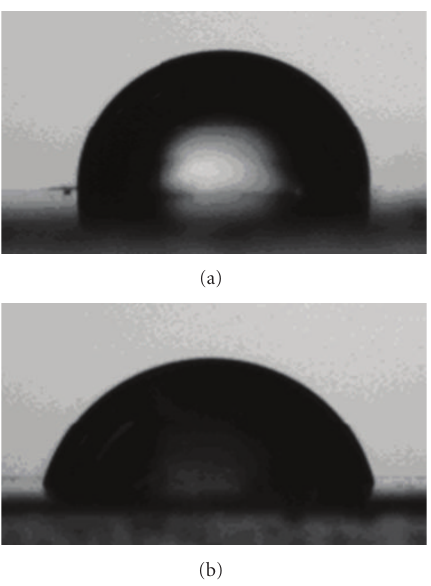
Figure 4: Di ff erences in the hydrophobic character of (a) Nafion- 112 and (b) Naf-112/DTA + membranes by the comparison of water- membrane surfaces contact angles.